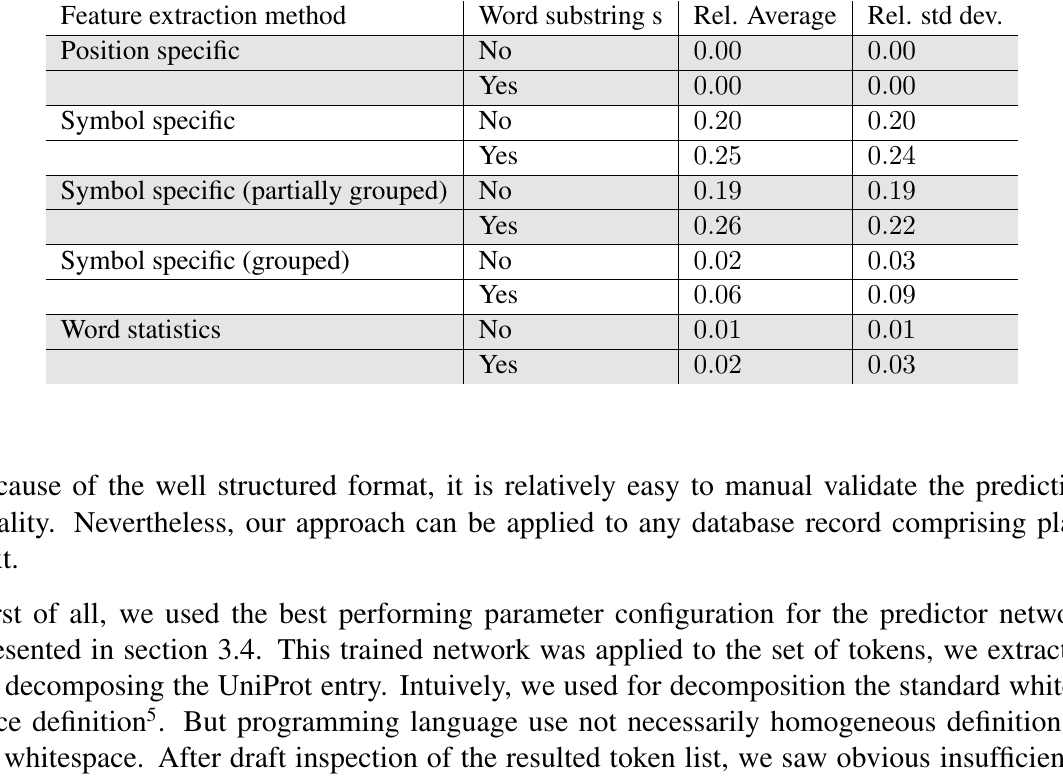
Table 4: Evaluation of the variable feature extraction strategy . In the first and second column, we list the ten feature extraction strategies introduced in section 2. In the third and forth column, we present the average and standard deviation of the evaluation score of equation (1) normalized to a sum of 1 and rounded to two positions after the decimal